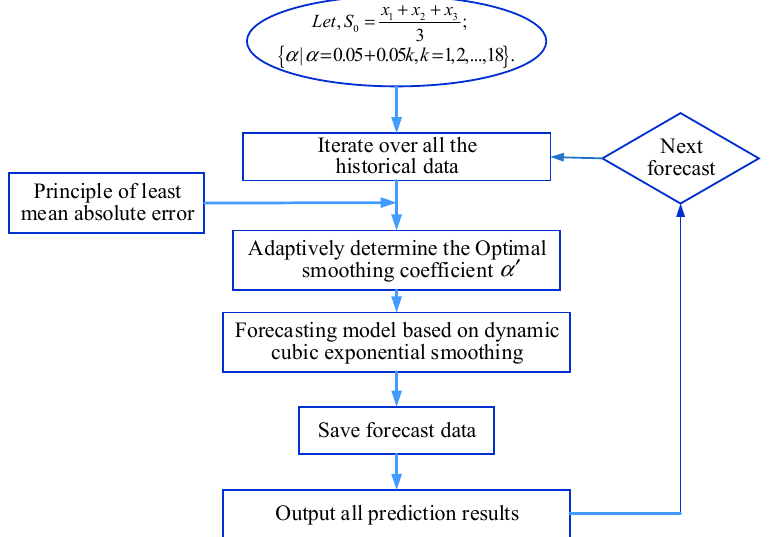
Figure 4. The calculation process of the adaptive exponential smoothing.